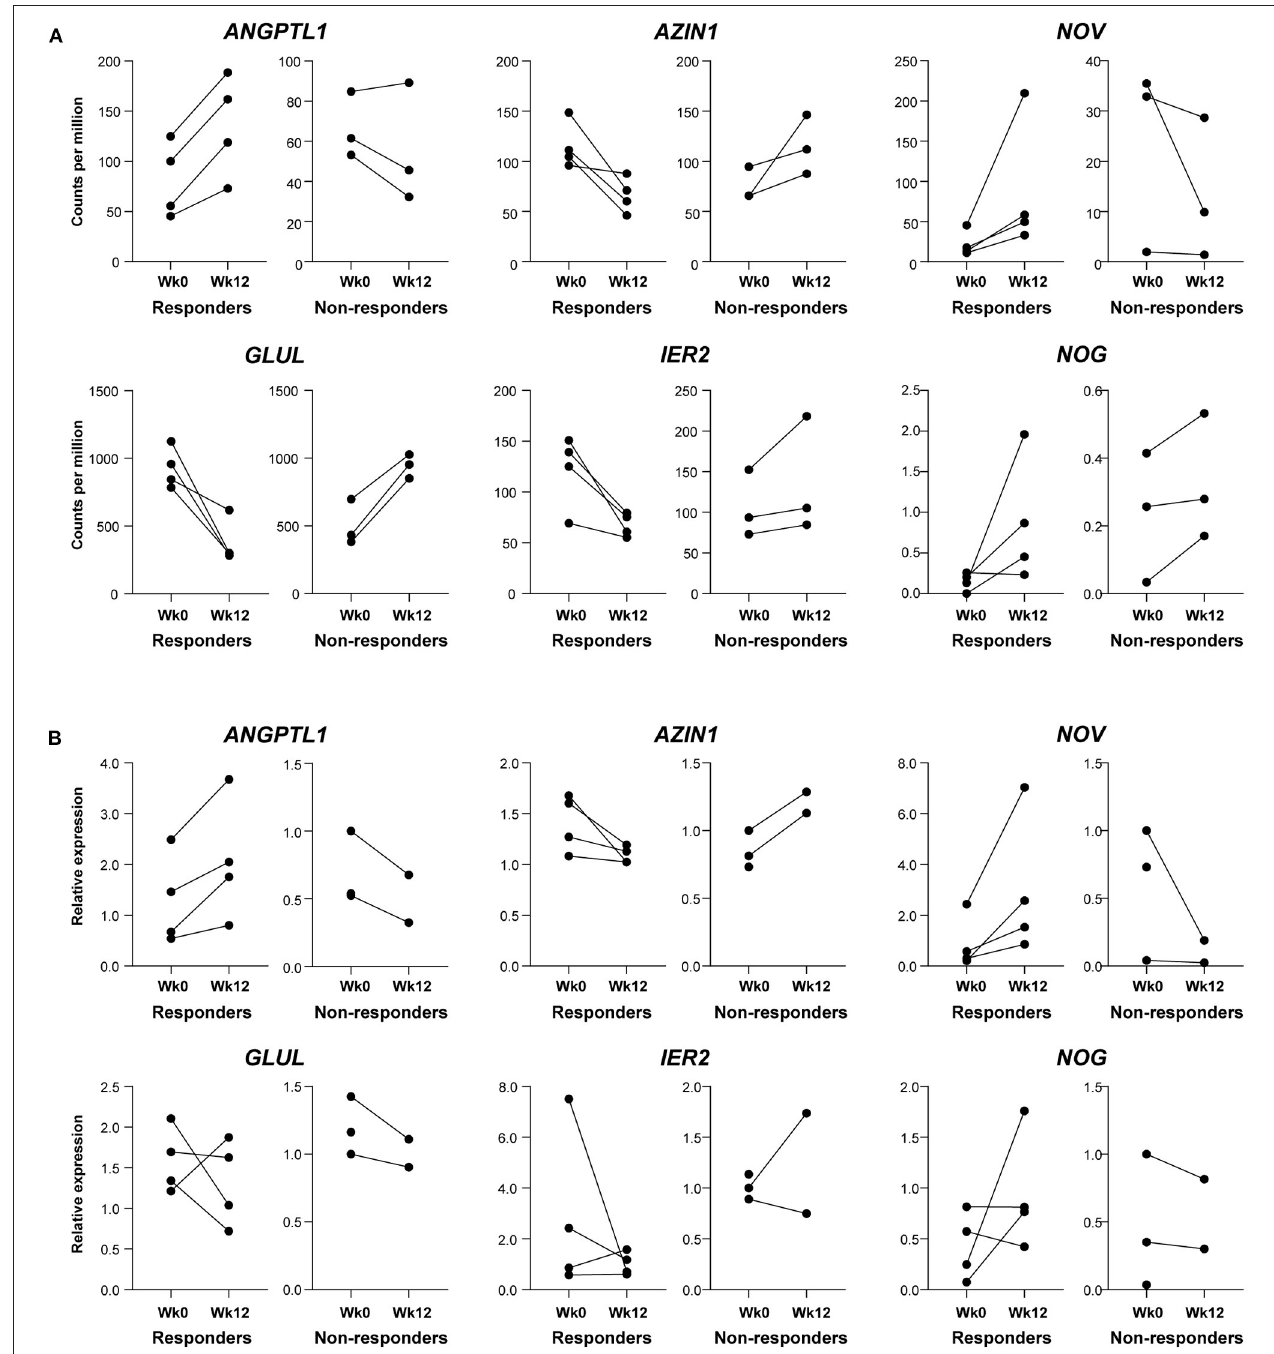
FIGURE 6 | Confirmation of difference in gene expression profiles of ACR20 responders and non-responders by qPCR. (A) Genes responding significantly different to ustekinumab treatment between ACR20 responders ( n = 4) and non-responders ( n = 3) in RNAseq analysis that were selected for validation. (B) Real-time quantitative polymerase chain reaction analysis of synovial tissue of baseline and after 12 weeks of ustekinumab treatment for angiopoietin-like 1 (ANGPTL1), antizyme inhibitor 1 (AZIN1), glutamine synthetase (GLUL), immediate early response 2 (IER2), noggin (NOG), and nephroblastoma overexpressed (NOV) confirm that ANGPTL1, AZIN1, and NOV levels go in opposite directions for ACR20 responders and non-responders.